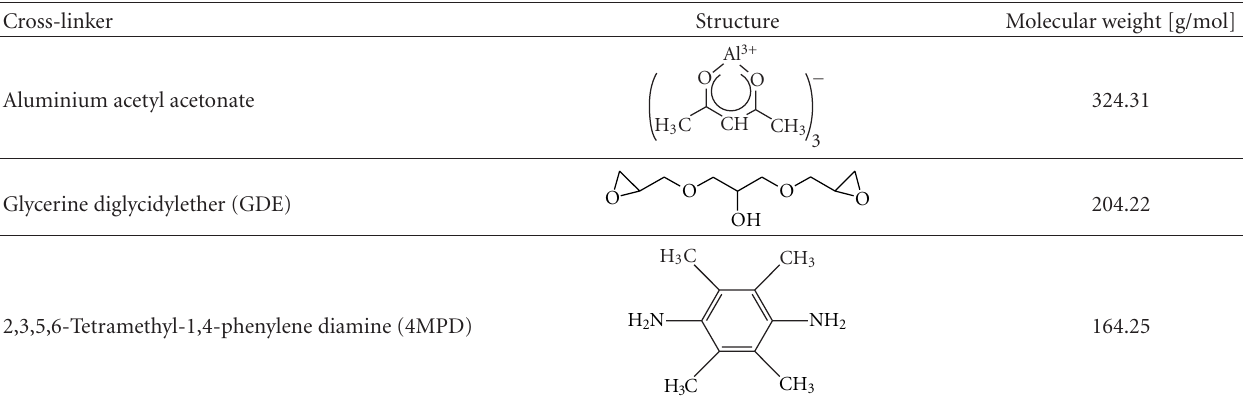
Table 2: Cross-linking agents